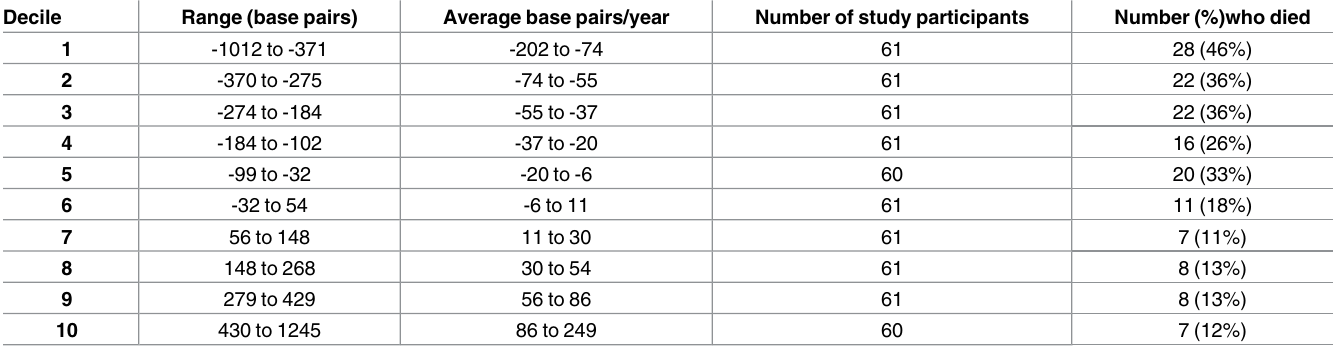
Table 2. Mortality by decile of 5-year telomere